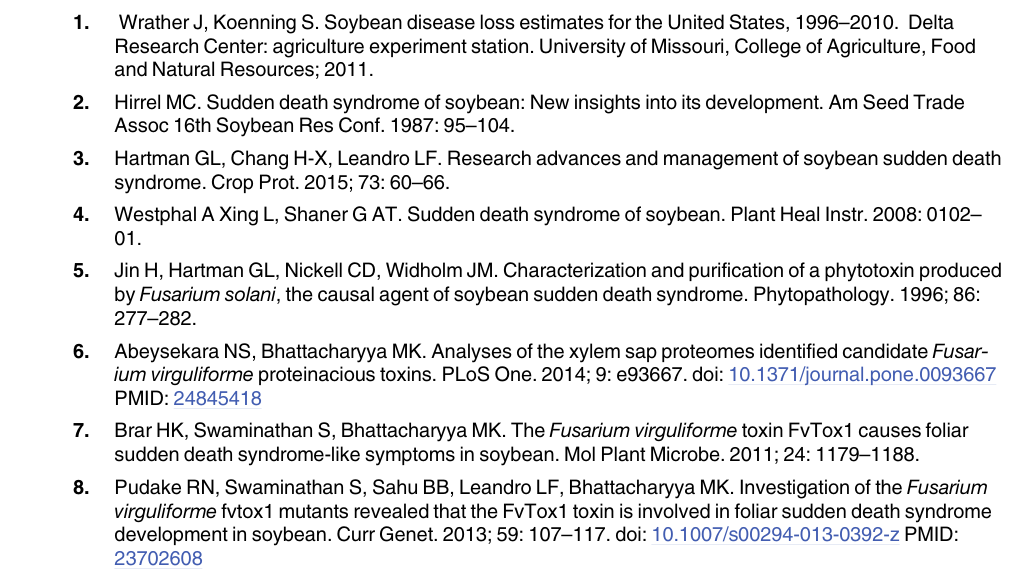
the FvTox1-interacting peptides. Chlorotic and necrotic leaf symptoms were recorded on day 8 following feeding of cut soybean seedlings with cell-free Fv culture filtrates that were pre- adsorbed with individual M13 phage displayed peptides with no His tags (Table 5).